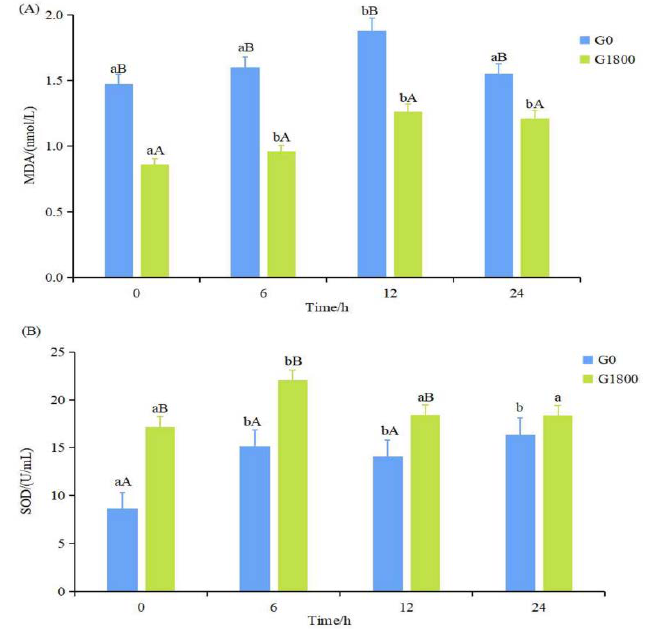
Figure 1. Effect of dietary GML supplementation on MDA content ( A ) and SOD activity ( B ) of grouper under salinity stress. Data represent means of three tanks in each group; error bar indicates S. D. Values with different letters are significantly different ( p < 0.05). “a, b” represents the significance between the same group at different times; “A, B” represents the significance between different groups at the same time period. The same as below. MDA: malondialdehyde; SOD: superoxide dismutase.